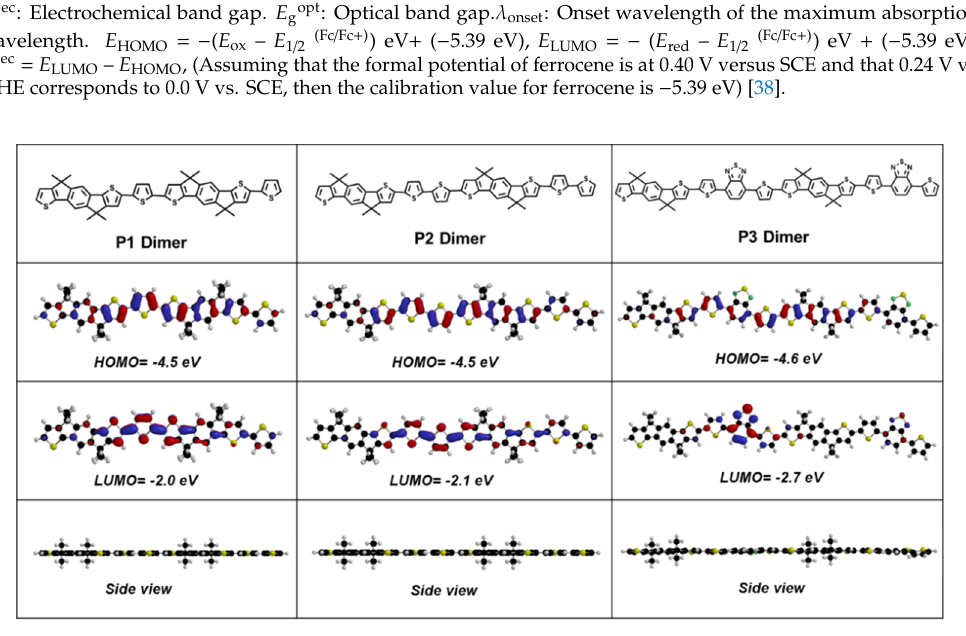
Figure 3. Molecular geometries and theoretical calculations for HOMO and LUMO energy levels of the model dimers of three polymers by density functional theory (DFT) calculations at the B3LYP / 6-31G (d, p) level (The alkyl chain is replaced by the methyl group for clarity).